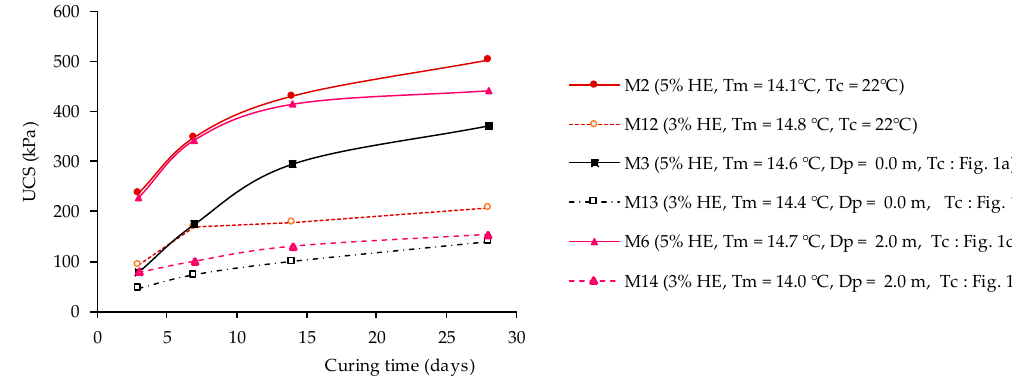
Figure 6. Evolution of the UCS in mixtures (M2, M3, and M6) containing 5% HE (full lines) and mixtures (M12–M14) containing 3% HE (dashed lines) cured under a constant temperature of 22 °C (M2 and M12) and under decreasing temperatures depending on the distance from the CPB–permafrost wall interface (Dp): 0 m (M3 and M13) and 2 m (M6 and M14).